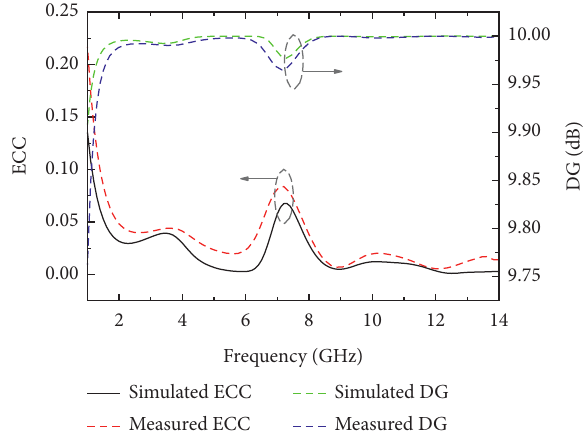
Figure 19: Simulation and measurement of ECC and DG results.